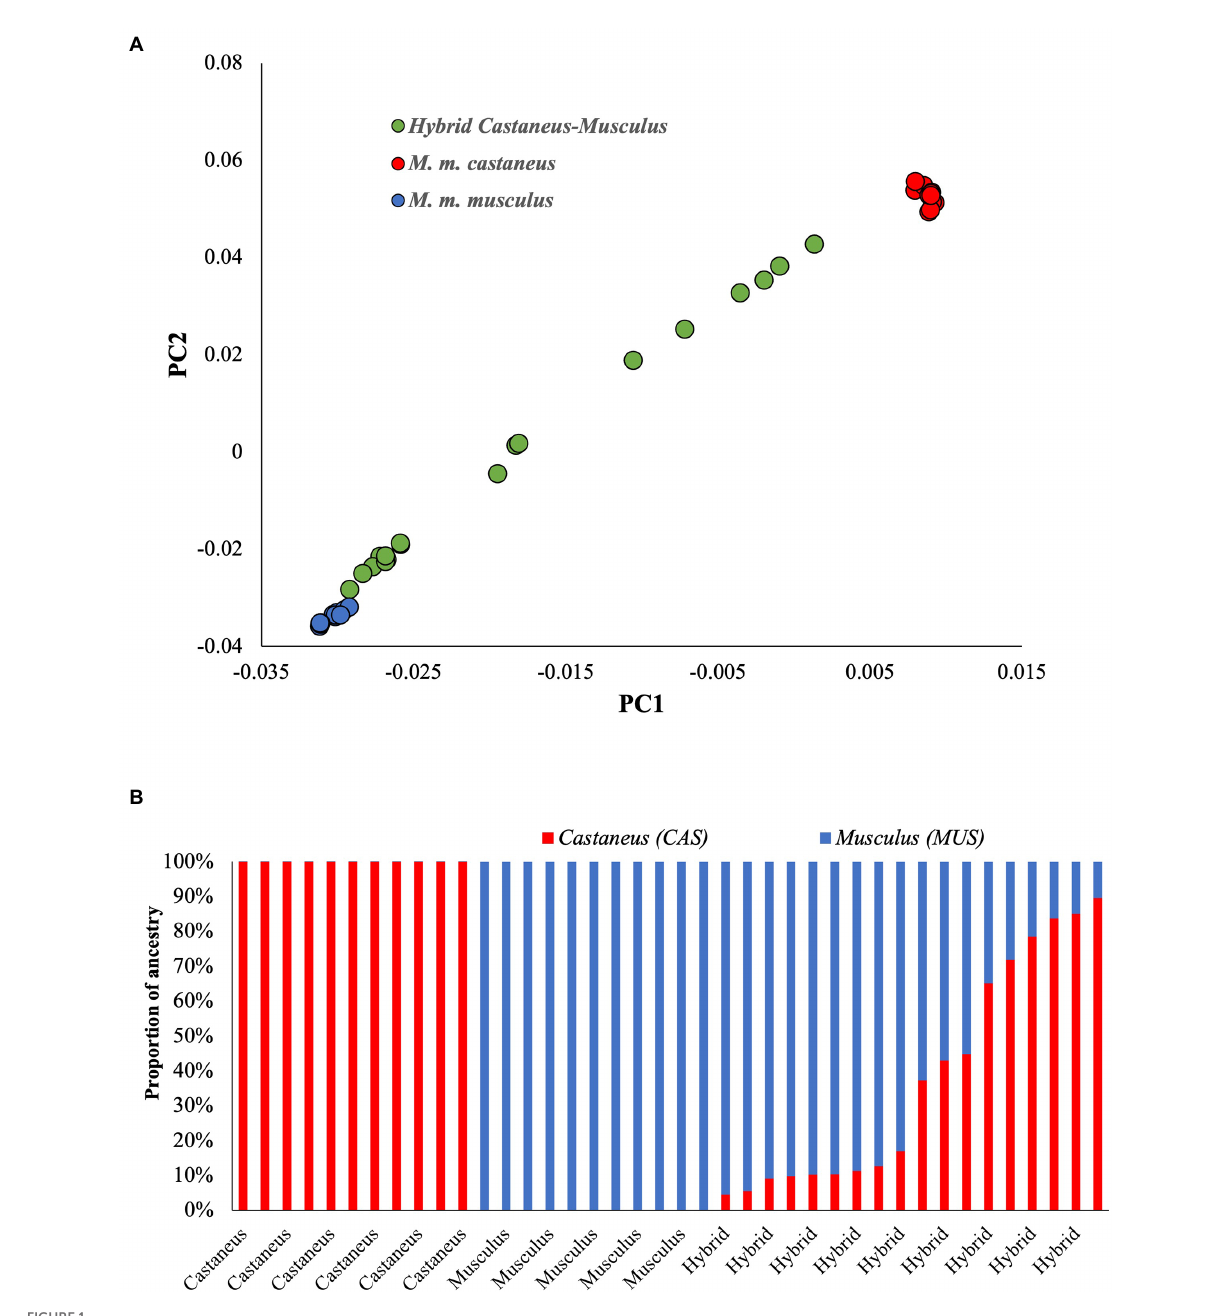
FIGURE 1 (A) Principal Component Analysis using pure and admixed mice populations. The pure populations ( Mus musculus castaneus and Mus musculus musculus ) are distinct and widely separated on the x -axis. In contrast, the admixed or hybrid populations spread between the parents. (B) The proportion of ancestries in each genome. Pure populations are shown in one colour, whereas the admixed individuals have two colours representing the proportions of different